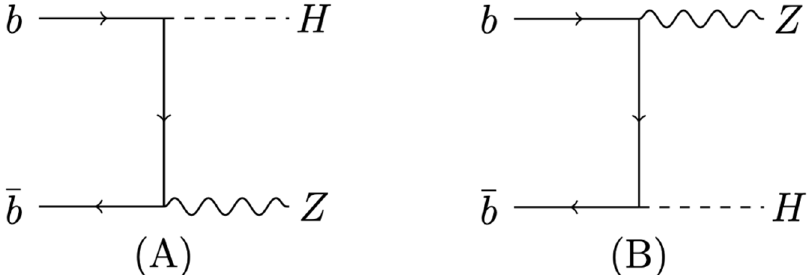
Figure 1 . Leading order Feynman diagrams that involve the bottom-Higgs Yukawa